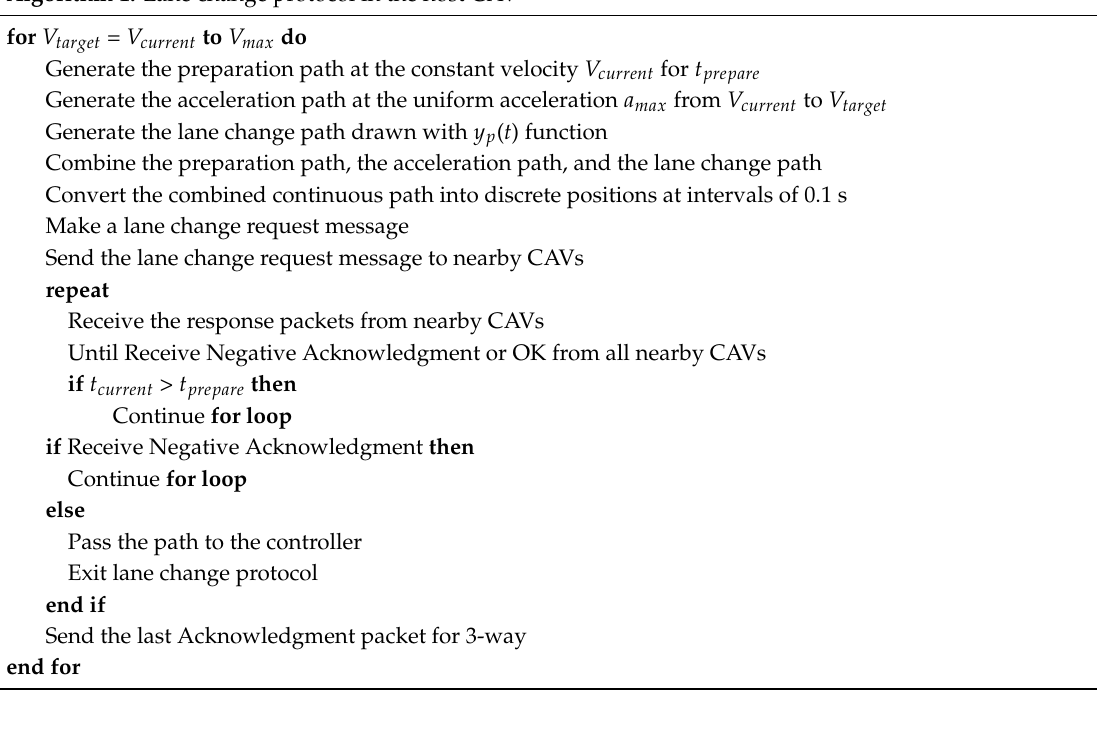
Algorithm 2. Lane change protocol in the nearby CAV Receive path from the host CAV